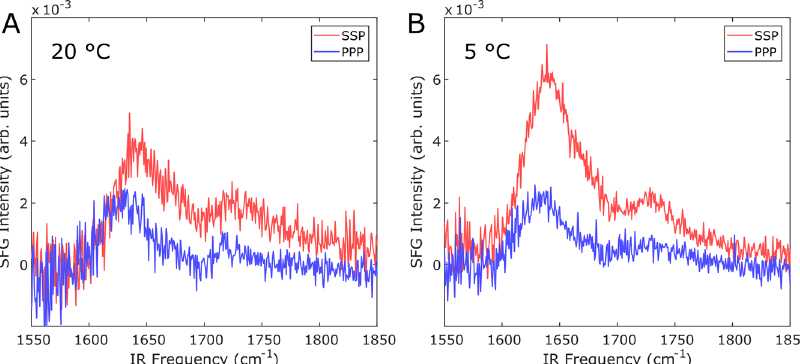
Fig. 4 Temperature-dependent amide-I SFG spectra of InaZ9R at the air – water interface in ssp and ppp polarization. A Spectra recorded at 20 °C show a resonance near 1630 cm − 1 related to β -sheet type structure and a resonance near 1720 cm − 1 related to lipids. B Spectra collected for 5 °C show a strong increase in amide-I ssp intensity, which indicates the protein has changed orientation at